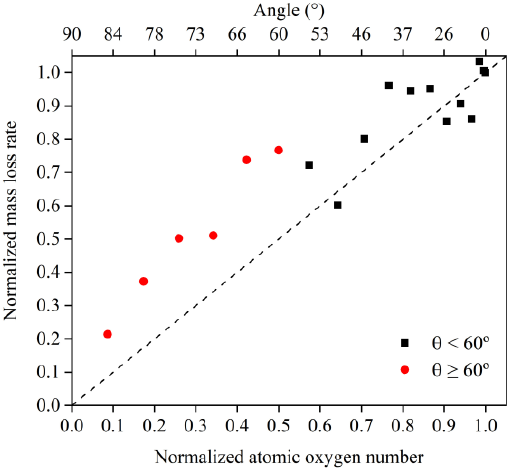
Figure 10. Mass loss rate information of the Kapton during atomic oxygen impact at different incidence angles.